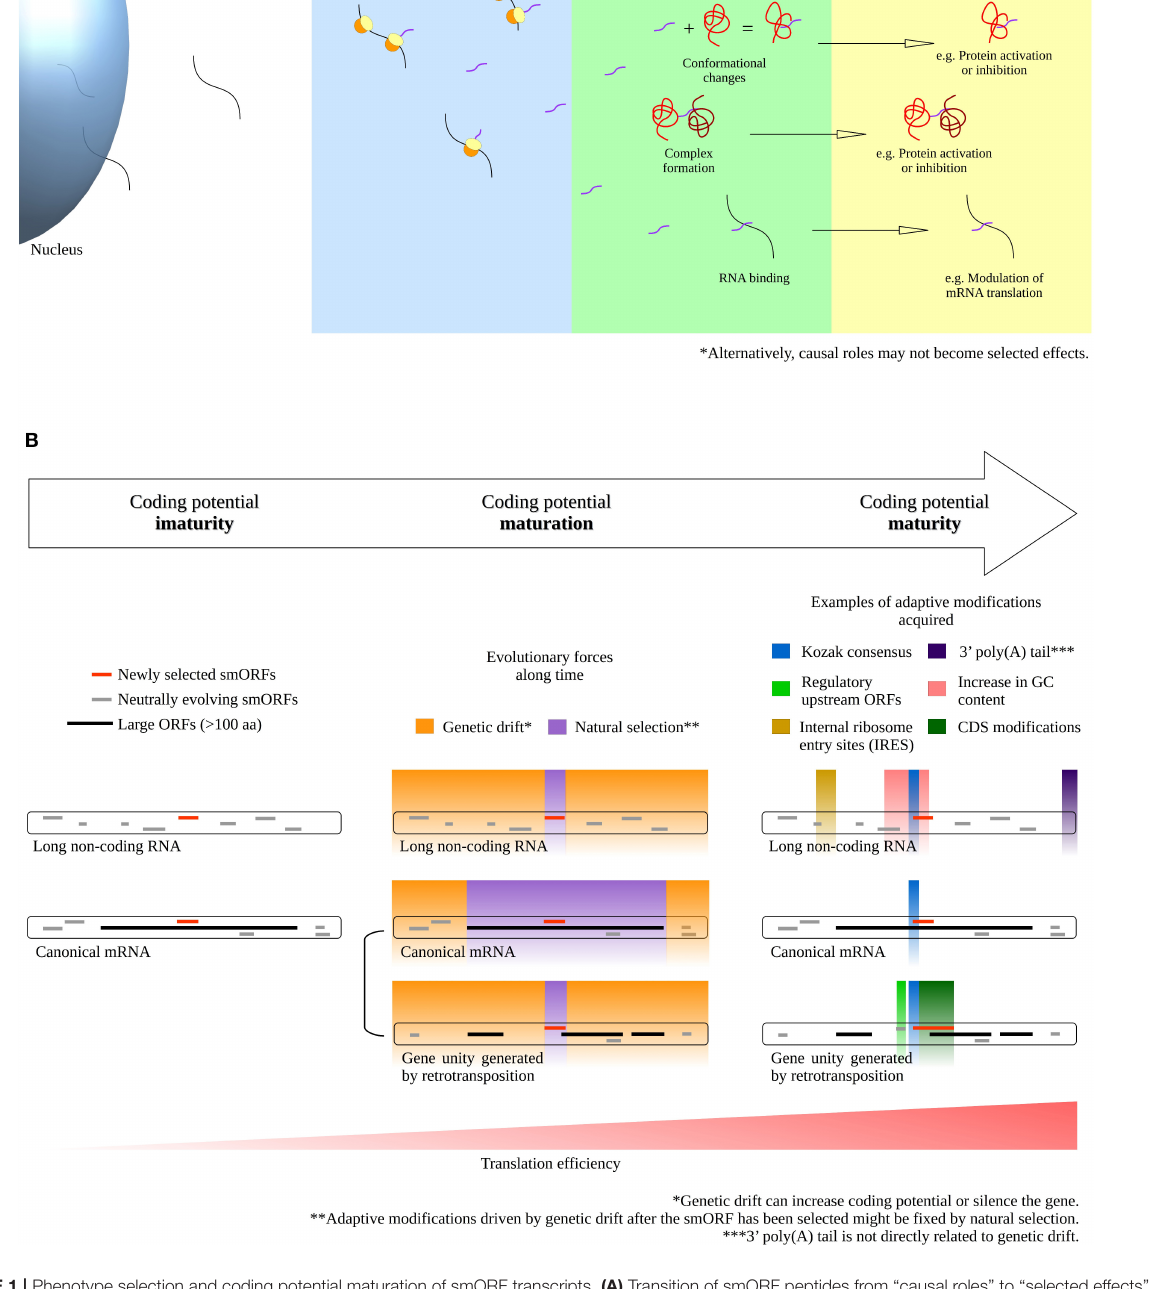
Frontiers in Genetics | www.frontiersin.org